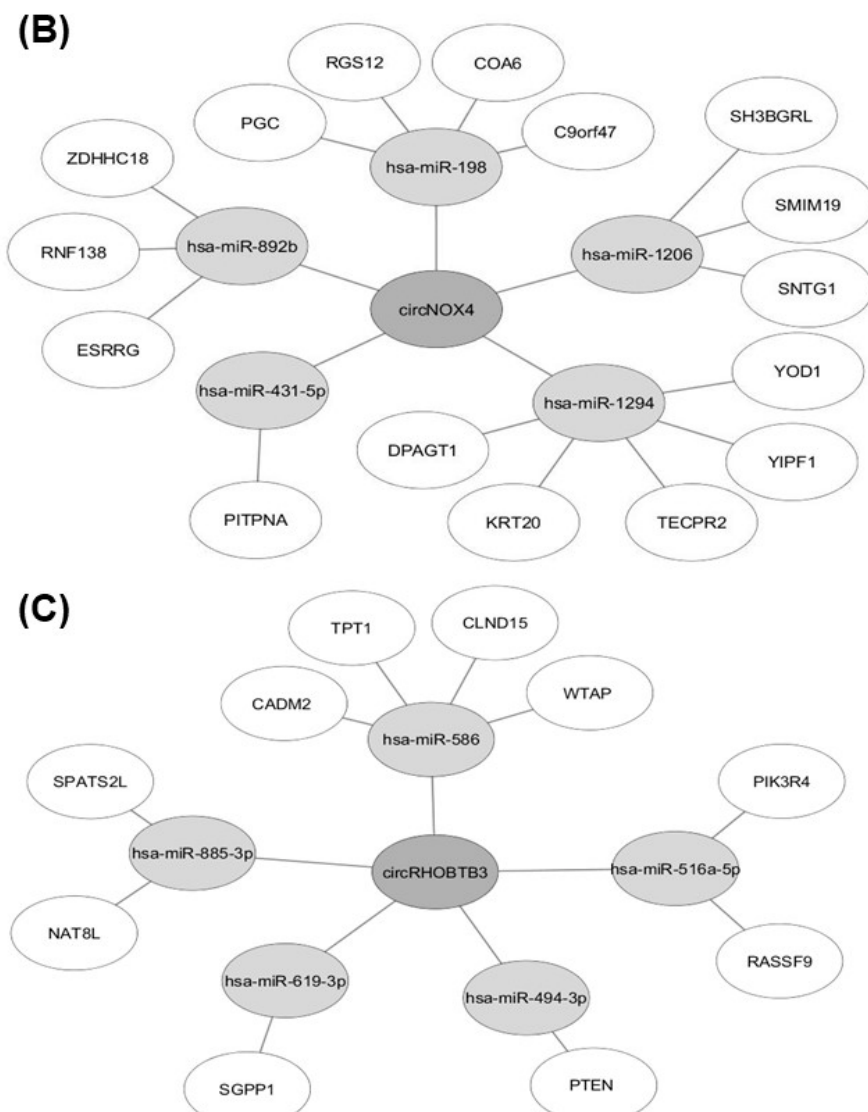
Figure 7. Results of in-silico analysis of circRNA-miRNA-gene interaction. MiRNAs with potential binding sites to ( A ) circEGLN3, ( B ) circNOX4, and ( C ) circRHOBTB3 were identified using CircInteractome [36] and subsequent miRNA-gene interactions were analyzed with the databases miRDB [38] and TargetScan [37].